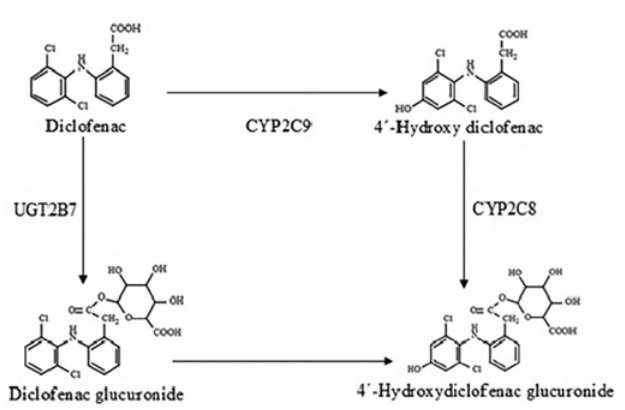
FIGURE 1 - Proposed primary metabolic pathways for diclofenac in